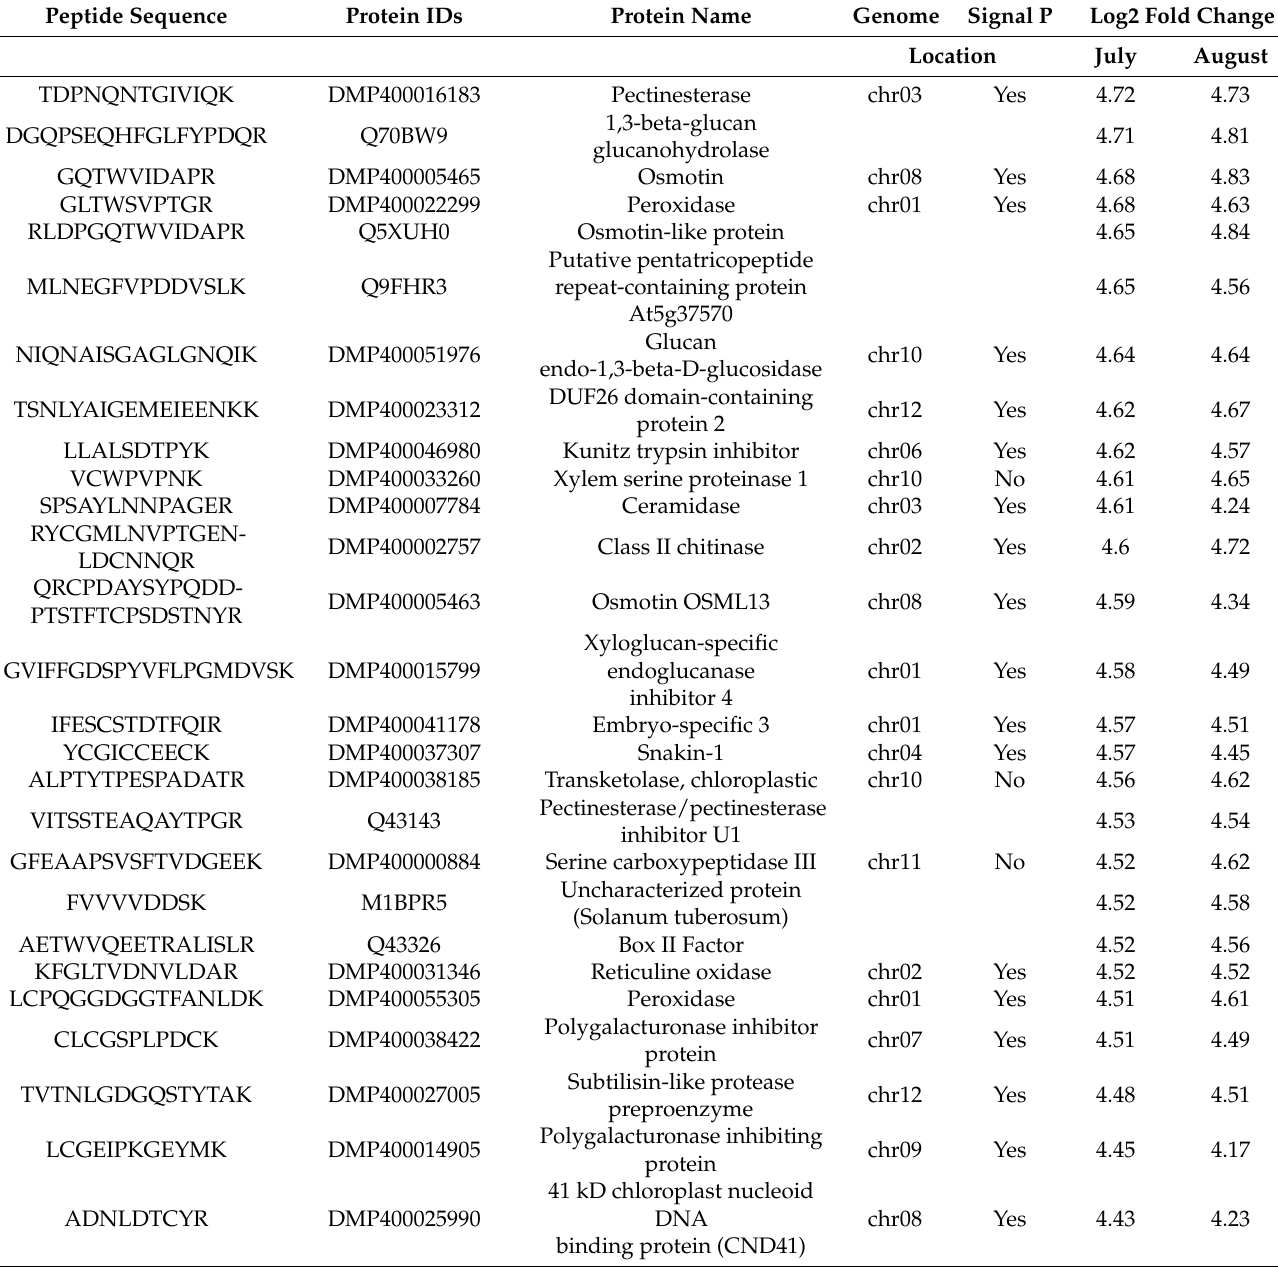
Table 1. Differentially abundant proteins in plants collected in June, July, or August in 2012 in fields in Mosslunda at false discovery rate < 0.001 (according to Benjamini − Hochberg), corresponding to the abundance pattern identified in STEM clustering profile 11 (Figure 3). Only unique peptides were used for the analysis. Shown are peptides with log 2 fold change ≥ 4 in July and August compared to their abundance in